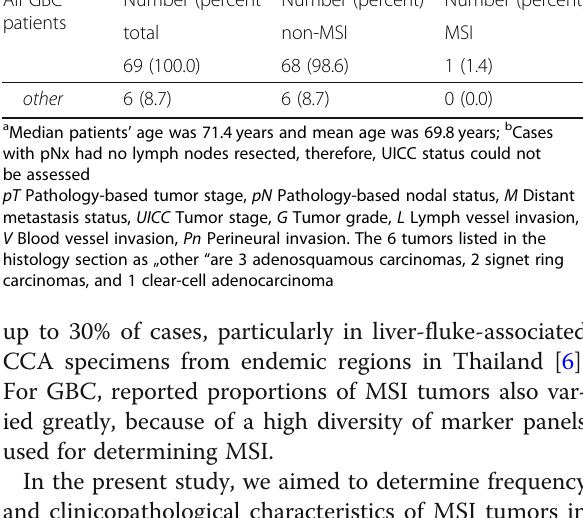
Table 1 Clinicopathological data of the gallbladder carcinoma cohort with complete clinicopathological data and correlation to the MSI status (n = 69) All GBC patients